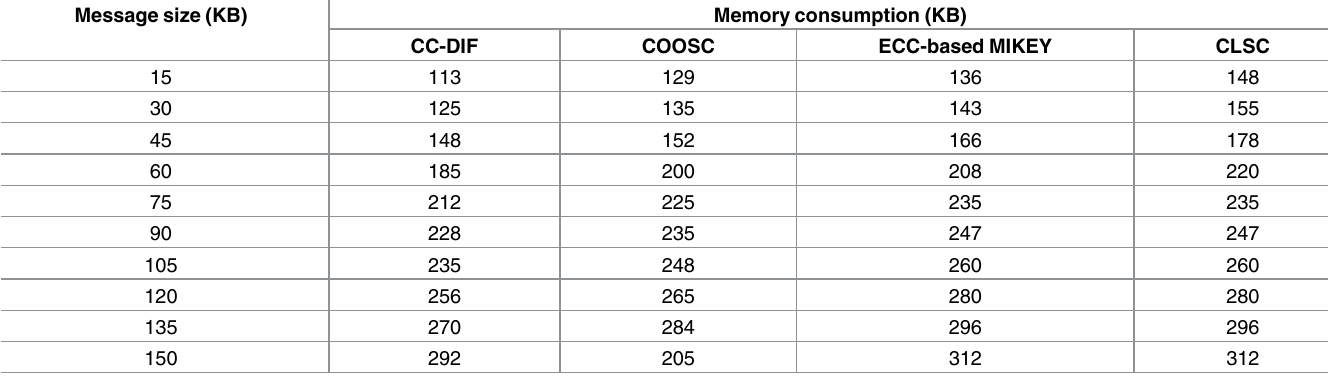
Table 3. Tabulation for memory